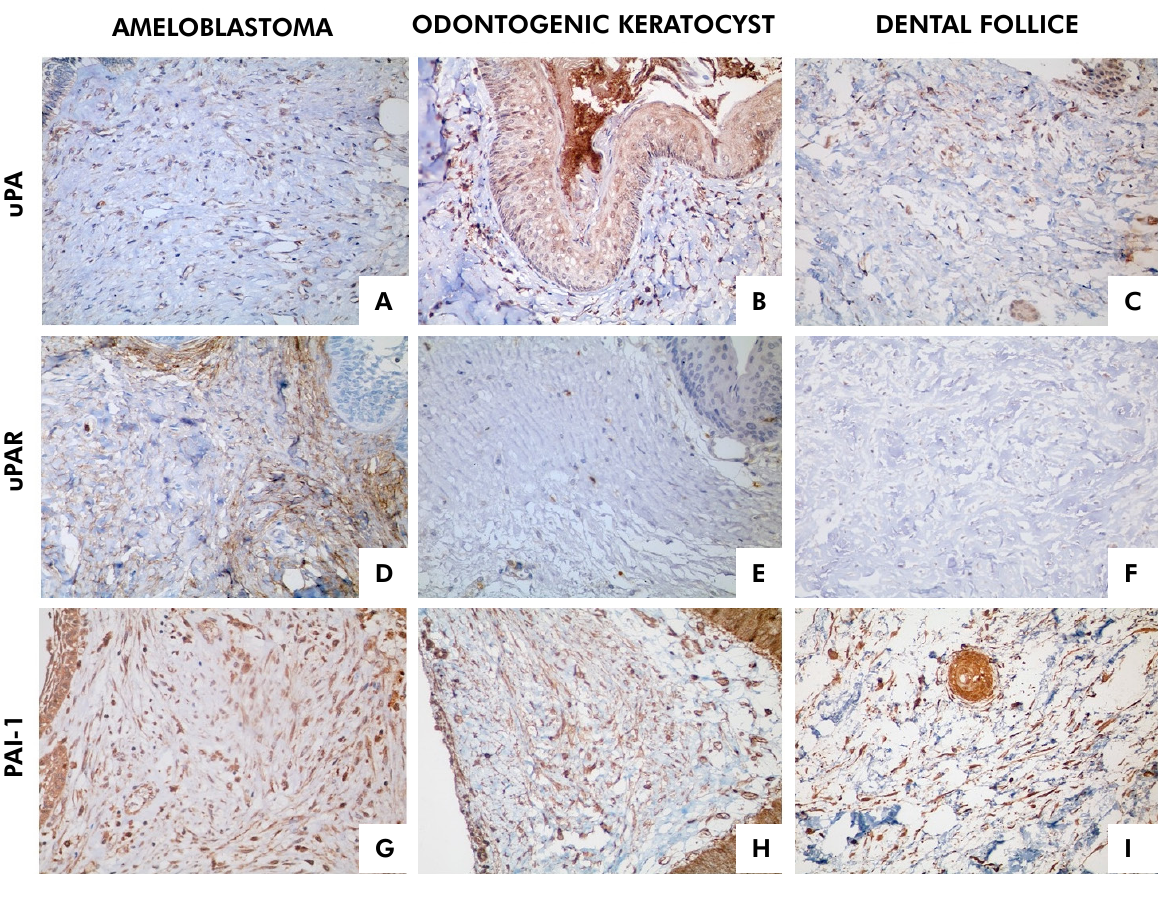
Figure 2. Immunohistochemical expression in connective tissue. uPA: (A) weak stromal staining in ameloblastoma; (B) moderate capsule staining in odontogenic keratocyst; (C) weak staining in dental follicle. uPAR: (D) moderate immunostaining in ameloblastoma; (E) low percentage of stained cells in odontogenic keratocyst; (F) few stained cells in dental follicle. PAI-1: (G) strong immunostaining in ameloblastoma; (H) moderate to strong staining in odontogenic keratocyst; (I) stained cells in dental follicle. Images captured at 400x